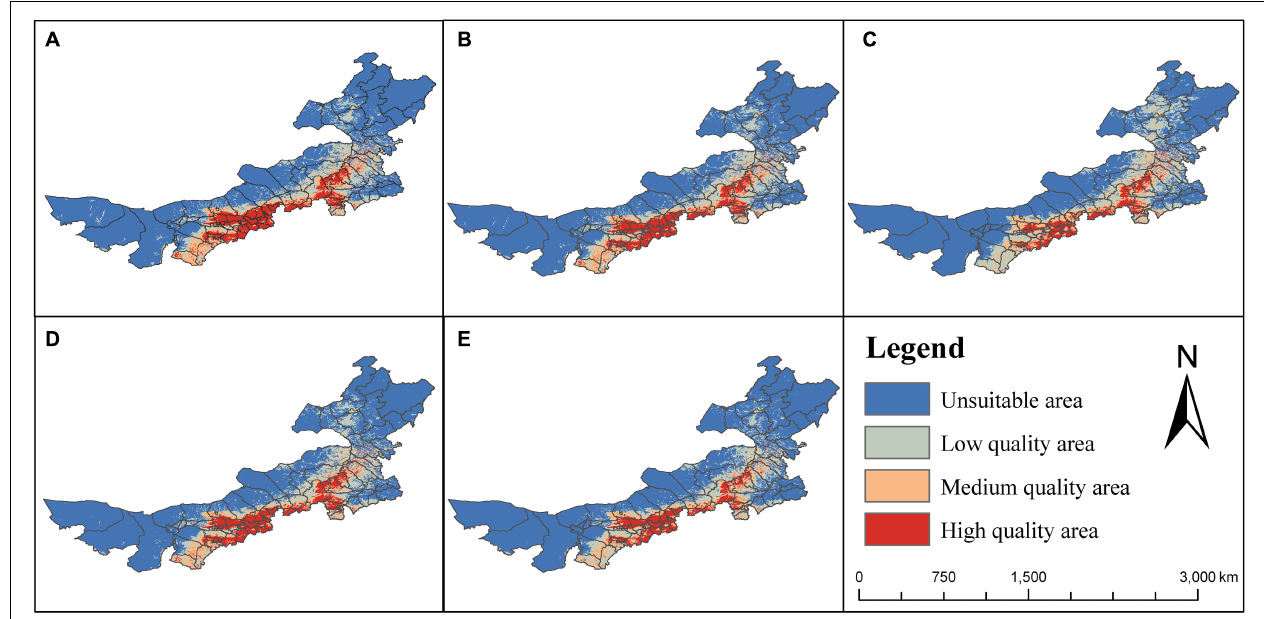
FIGURE 6 | Regional suitability maps of high-quality Gentiana dahurica in Inner Mongolia. The suitability is based on swertiamarin (A) , gentiopicroside (B) , sweroside (C) , total amount of loganic acid and gentiopicroside (D) , and total iridoid (E) contents.